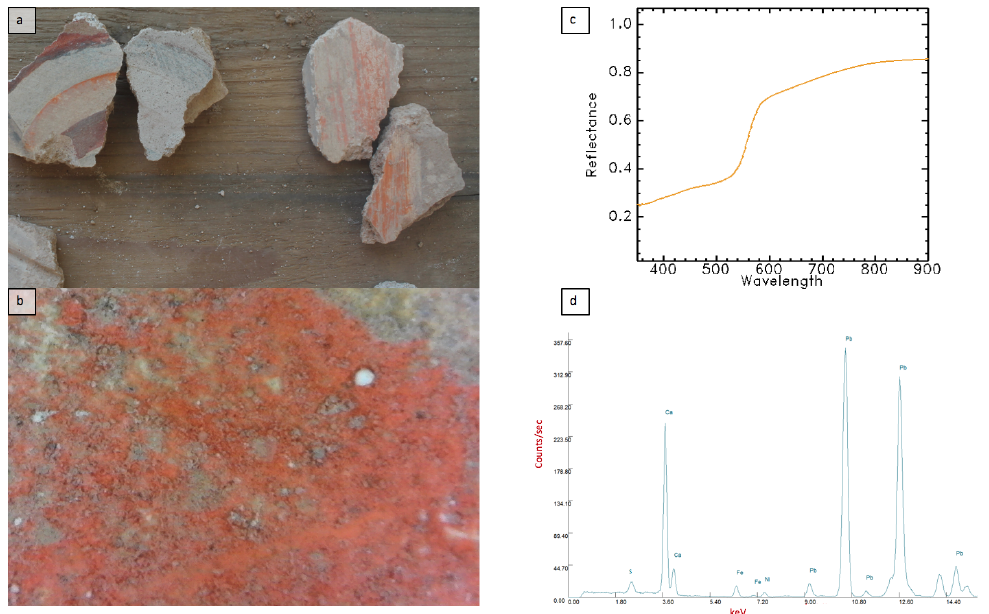
Figure 15. ( a ) Fragments featuring red lead from the House of the Four Seasons (A1); ( b ) Micrograph (250x) of a fragment from the Hellenistic House (C5); ( c ) reflectance spectrum and ( d ) XRF spectrum of a fragment from the House of the Four Seasons (A1).